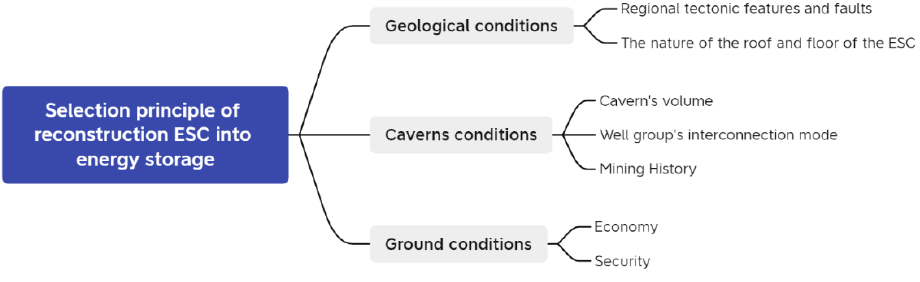
Figure 5. Screening ideas for reuse of the existing salt cavern.